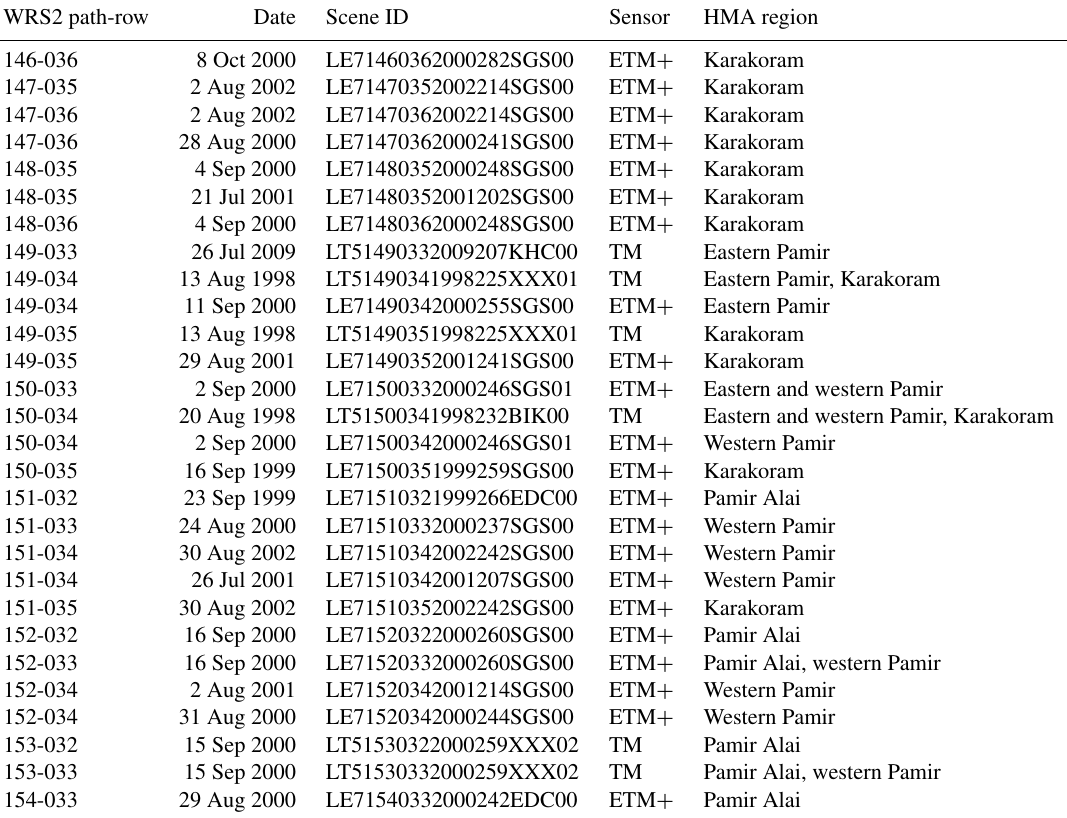
Table 1. List of Landsat scenes used to compile the inventory. WRS2